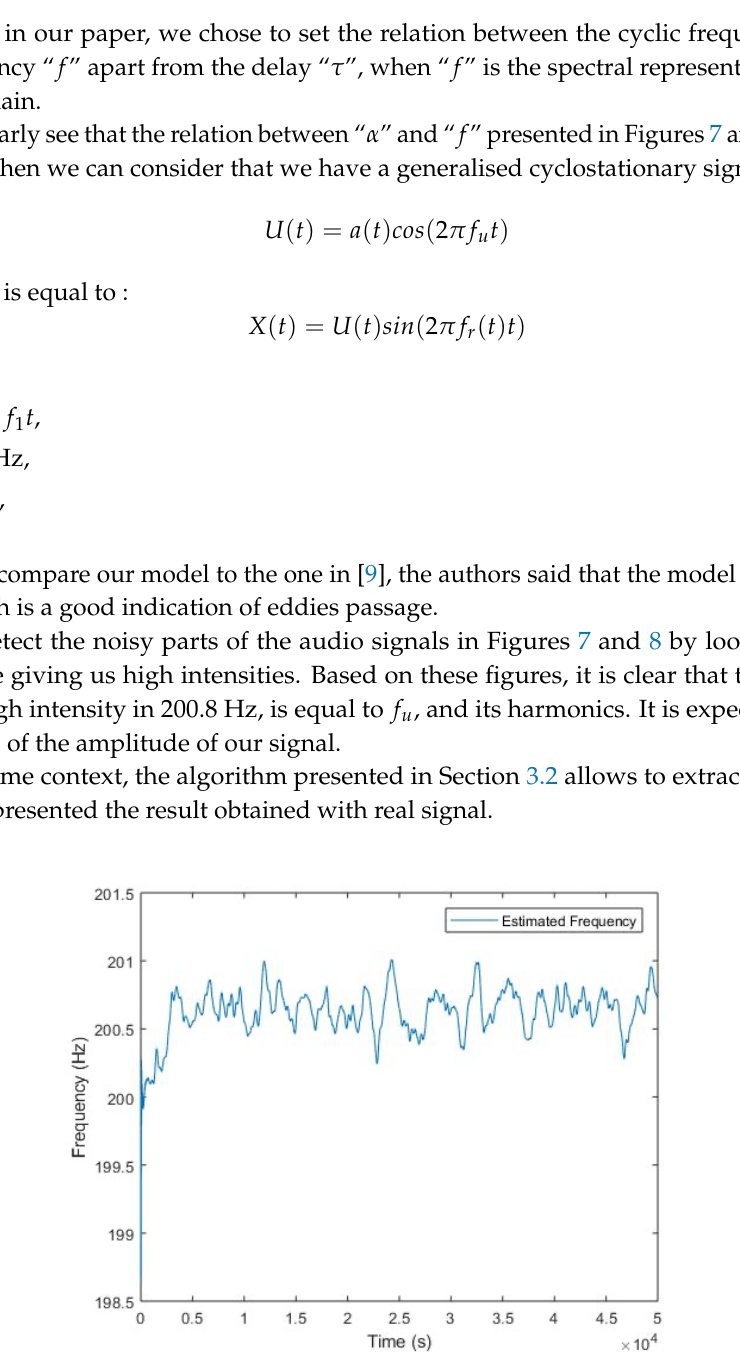
Figure 11. Real time extraction of